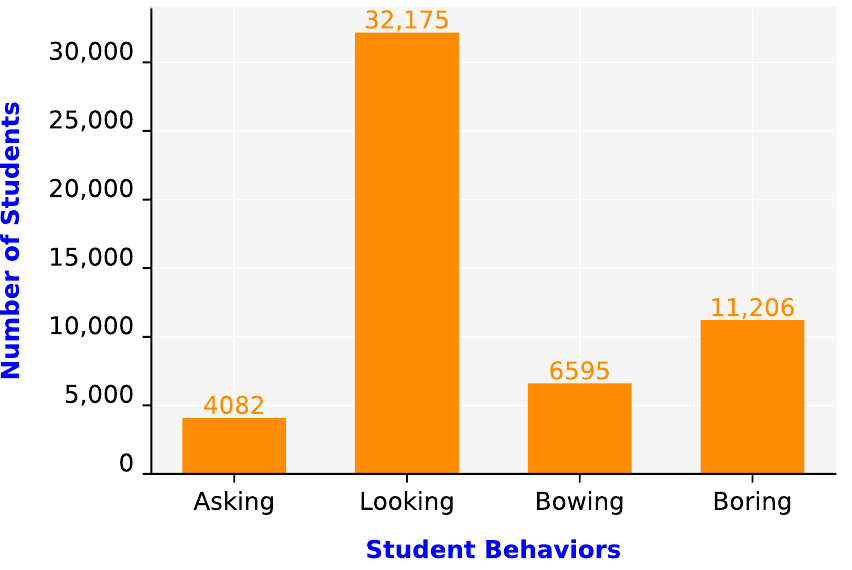
Figure 15. Results of student behavior